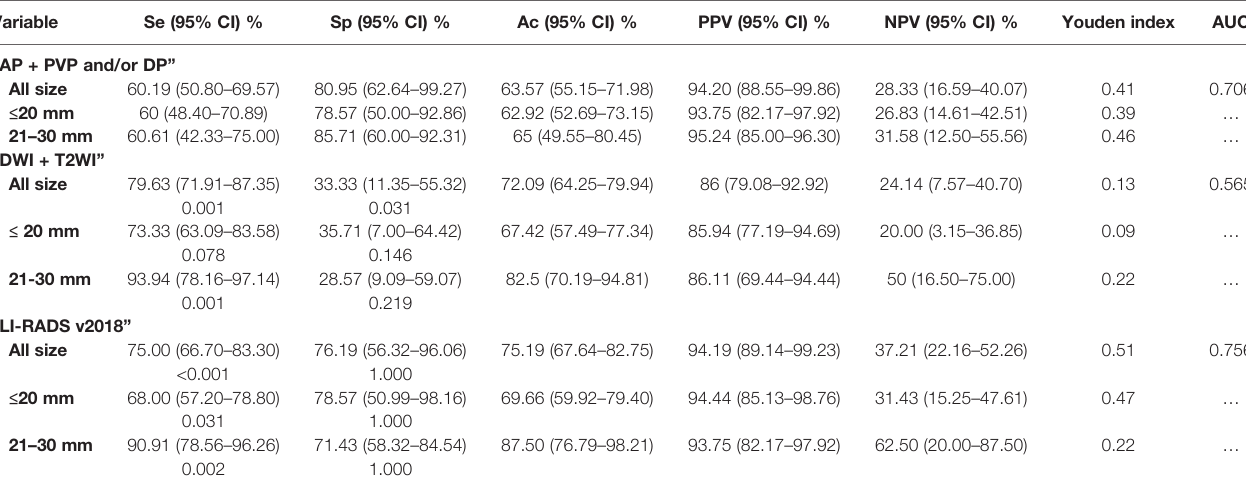
TABLE 5 | Diagnostic performance of these criteria using ECA-MRI with different tumor size.